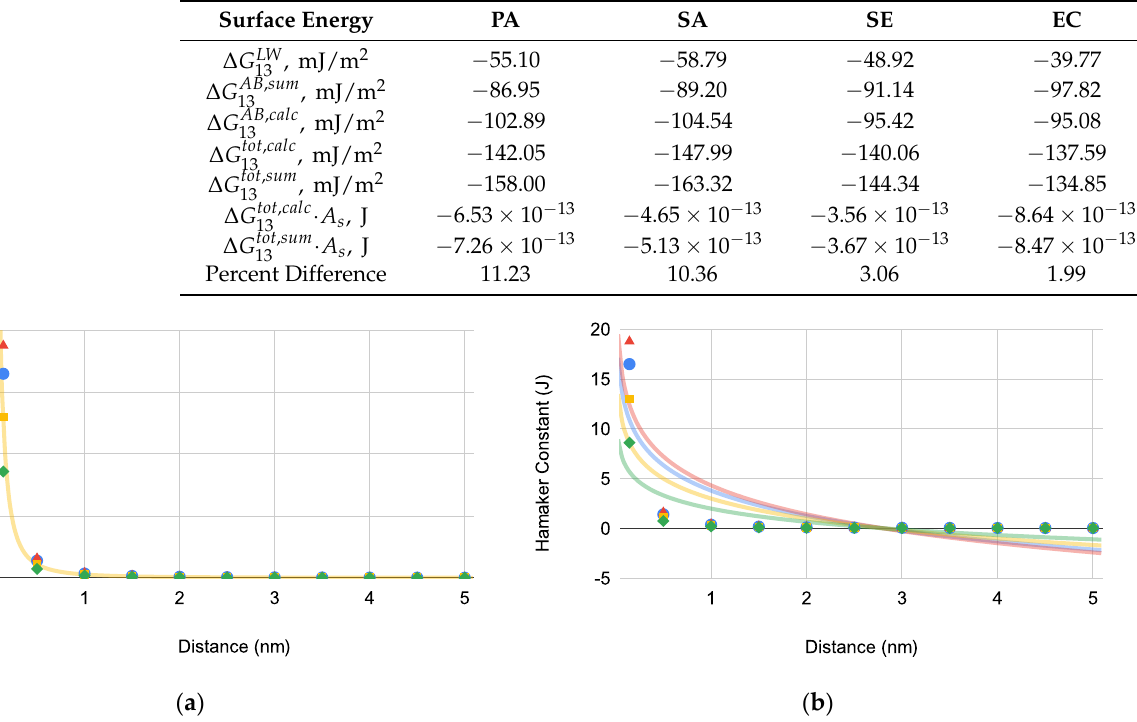
Figure 1. Hamaker constants ( × 10 −21 ) versus distance for PA (blue circles), EC (green diamonds), SA (red triangles), and SE (orange squares): ( a ) bacterial Hamaker constant determination ( 𝐻 1𝑃𝐴 = 3.46 × 10 −22 𝐽 , 𝐻 1𝑆𝐴 = 3.94 × 10 −22 𝐽 , 𝐻 1𝑆𝐸 = 2.73 × 10 −22 𝐽 , and 𝐻 1𝐸𝐶 = 1.80 × 10 −22 𝐽 ) and ( b ) bacterial equilibrium distance ( 𝑑 𝑒𝑞 ) determination where 𝑑 𝑒𝑞 is 2.80 ± 0.00479 nm ( N = 4).